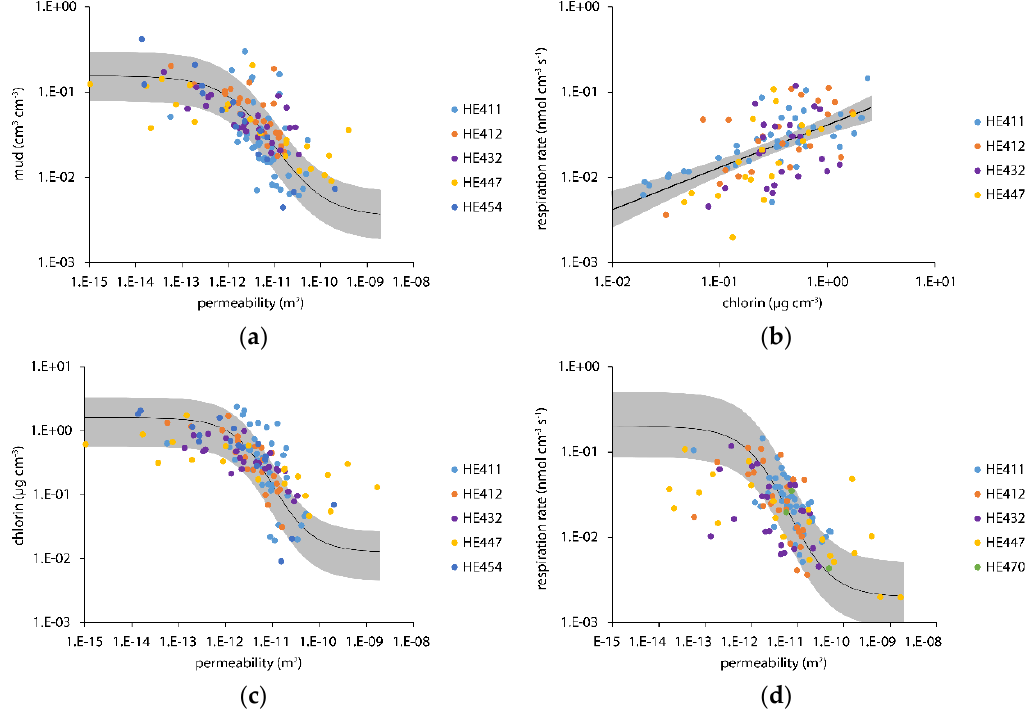
Figure 6. ( a ) Correlation of the fine mineral particles (mud) content from laser diffraction with the permeability. ( b ) Correlation of the specific respiration rate with the chlorin content. Correlation of the permeability with ( c ) the chlorin content, and ( d ) the specific respiration rate. The solid lines indicate the best-fit regression, grey bands indicate confidence intervals, and colours indicate the individual sampling cruises.